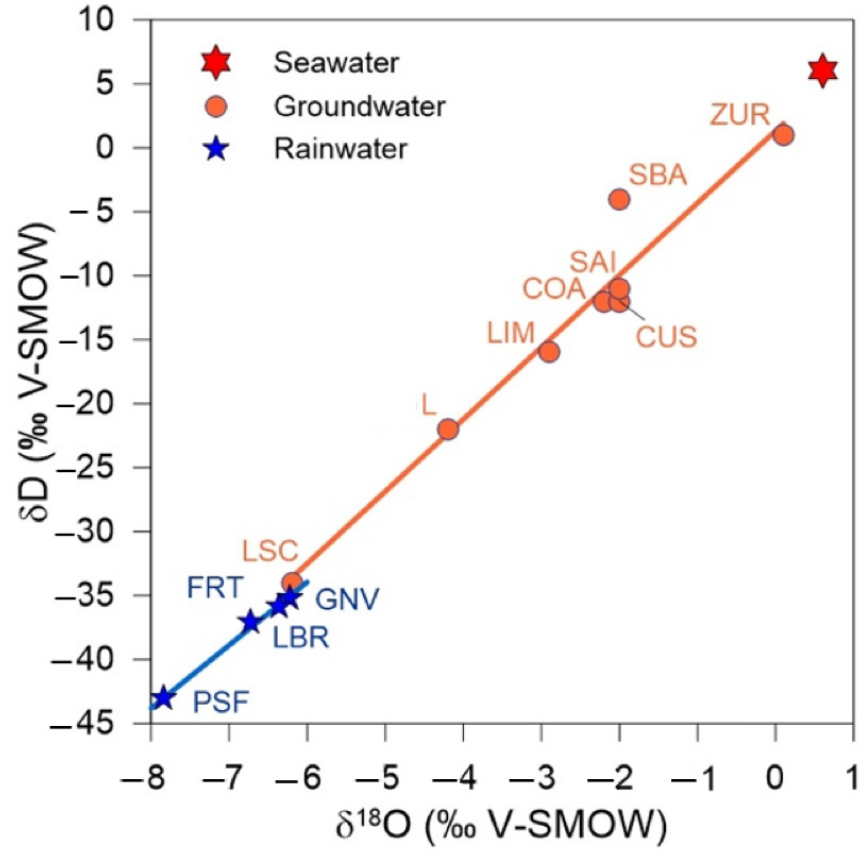
Figure 9. δ 18 O vs. δ D diagram reporting the isotopic composition of the groundwater [11], rainwa- ter [19], and seawater [11] of Stromboli Island. The blue line is the best fit of the rain compositions, and the orange one is the best fit of the groundwater samples.